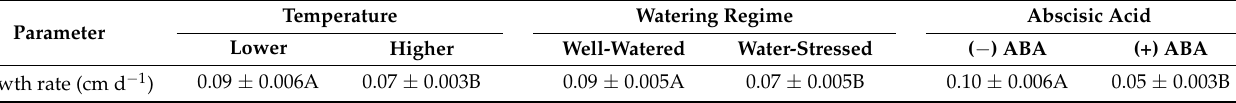
Table 4. Effects of temperature, watering regime and abscisic acid on growth rate of tomato